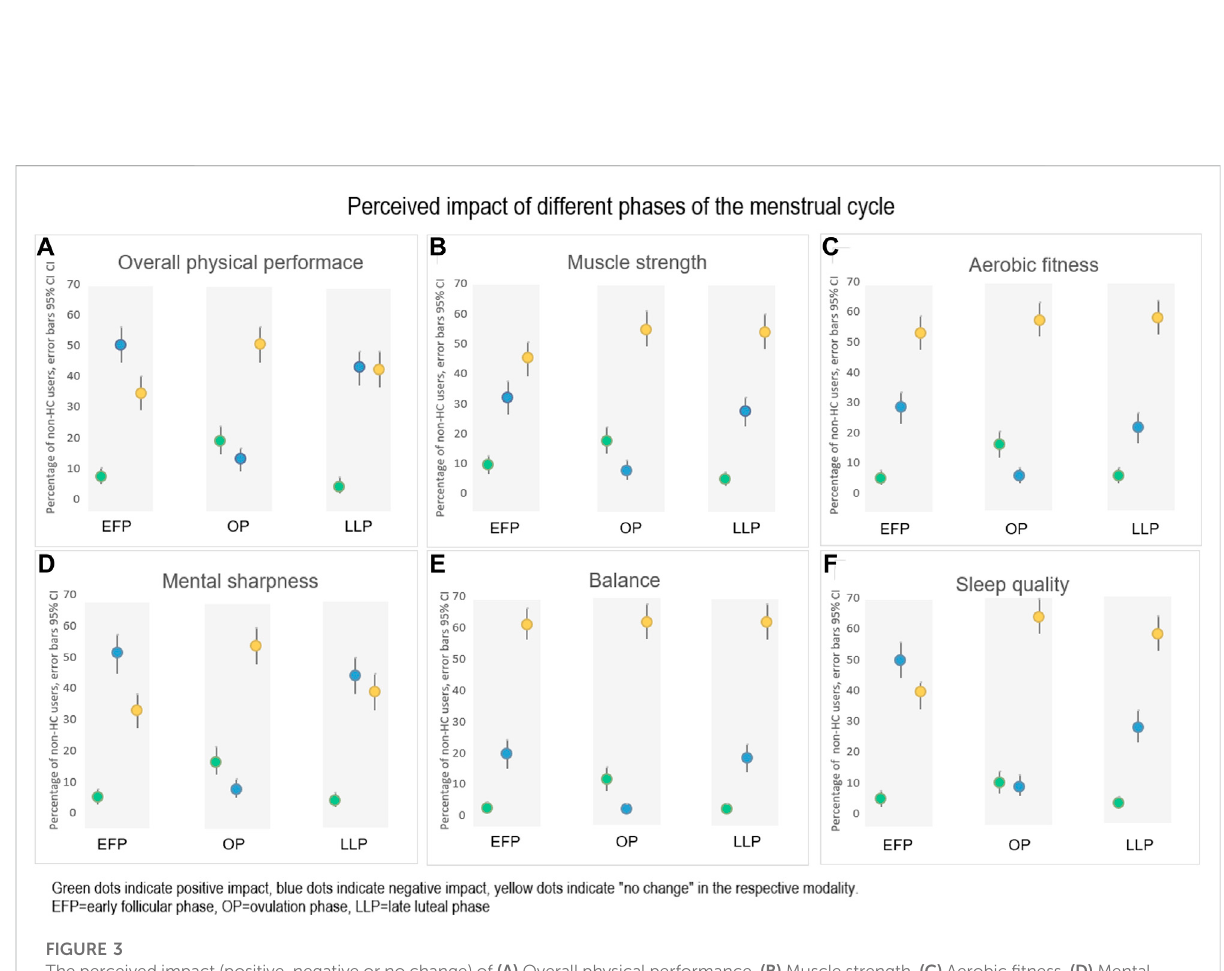
FIGURE 3 The perceived impact (positive, negative or no change) of (A) Overall physical performance, (B) Muscle strength, (C) Aerobic fi tness, (D) Mental sharpness, (E) Balance and (F) Sleep quality, during different phases of the menstrual cycle ( n = 299 in each phase). A proportion of 6% – 24% of the athletes answered “ I do not know ” on perceived impact for the different modalities, respectively (data not